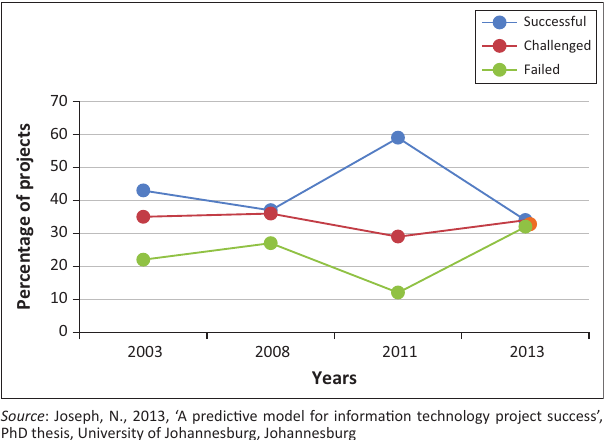
FIGURE 1: South Africa software projects performance